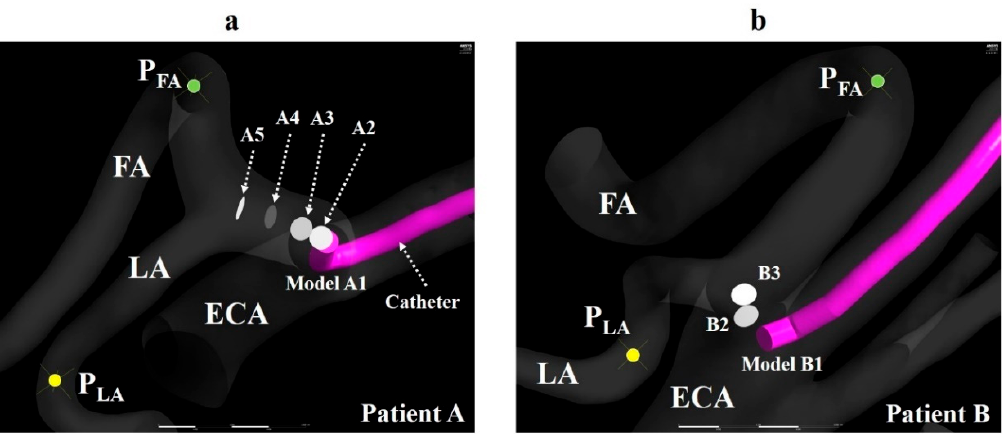
Figure 3. Catheter tip location. ( a ) The catheter tip position (A1–A5) and observation points (P FA and P LA ) of the LA and FA in model A. ( b ) The catheter tip position (B1–B3) and observation points (P FA and P LA ) of the LA and FA in model B. The walls of the catheter in models A2–A5 and B2–B3 are hidden. ECA, external carotid artery; FA, facial artery; LA, lingual artery.